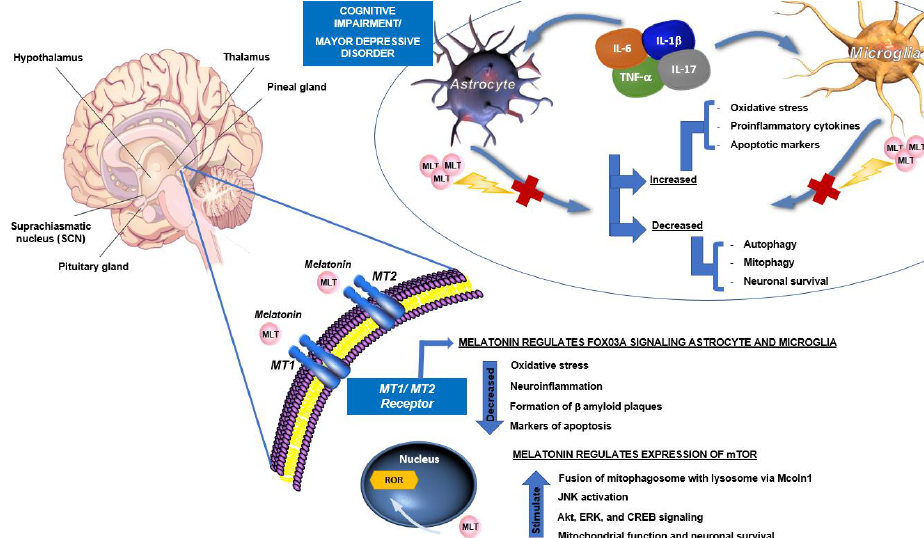
Figure 6. Effects of melatonin in major depressive disorder and cognitive impairments. The pathological process of neurological diseases involves an increase in oxidative stress and an increase in proinflammatory cytokines that stimulate astrocytes and activate microglia. In contrast, by interacting with M2 receptors, melatonin decreases oxidative stress and neuroinflammation. ED Torres-Sánchez modified this image, obtained from the Creative Commons BY base of an unknown author and QIAGEN’s original.